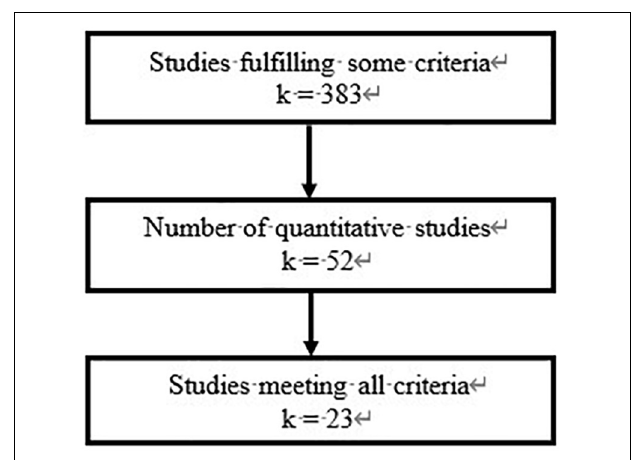
FIGURE 1 | Literature screening process ( k denotes the number of